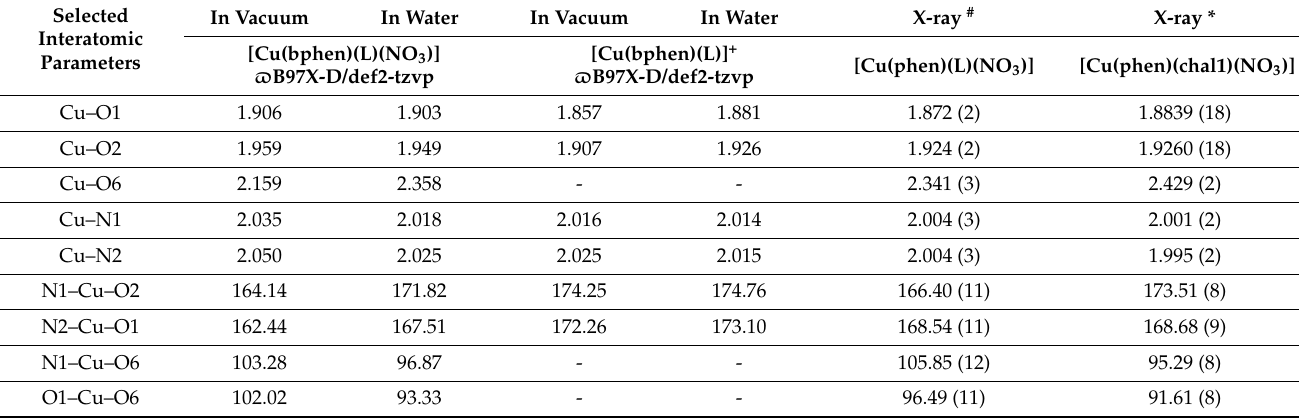
# Data published in this work, see Section 3.3. * Data adopted from ref.